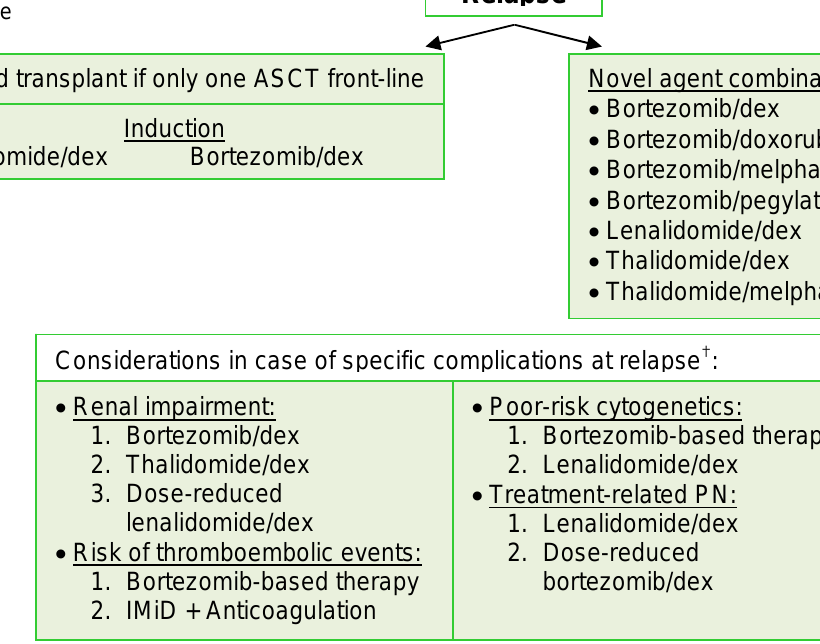
Figure 1b: Transplant setting – treatment at relapse *alphabetical order † order of